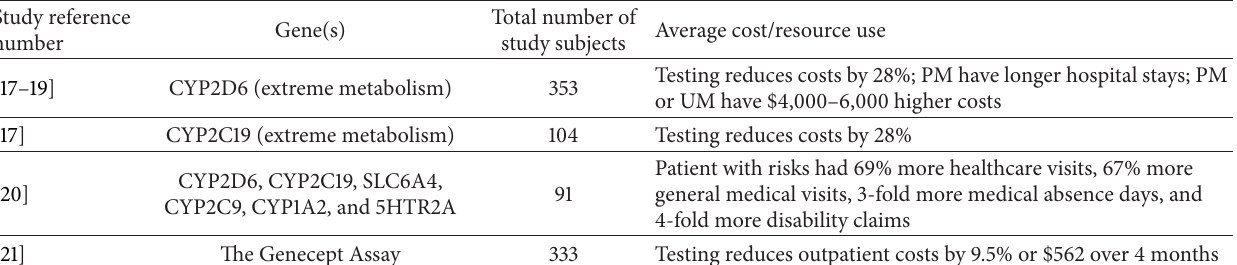
Table 1: Cost effectiveness of genetic